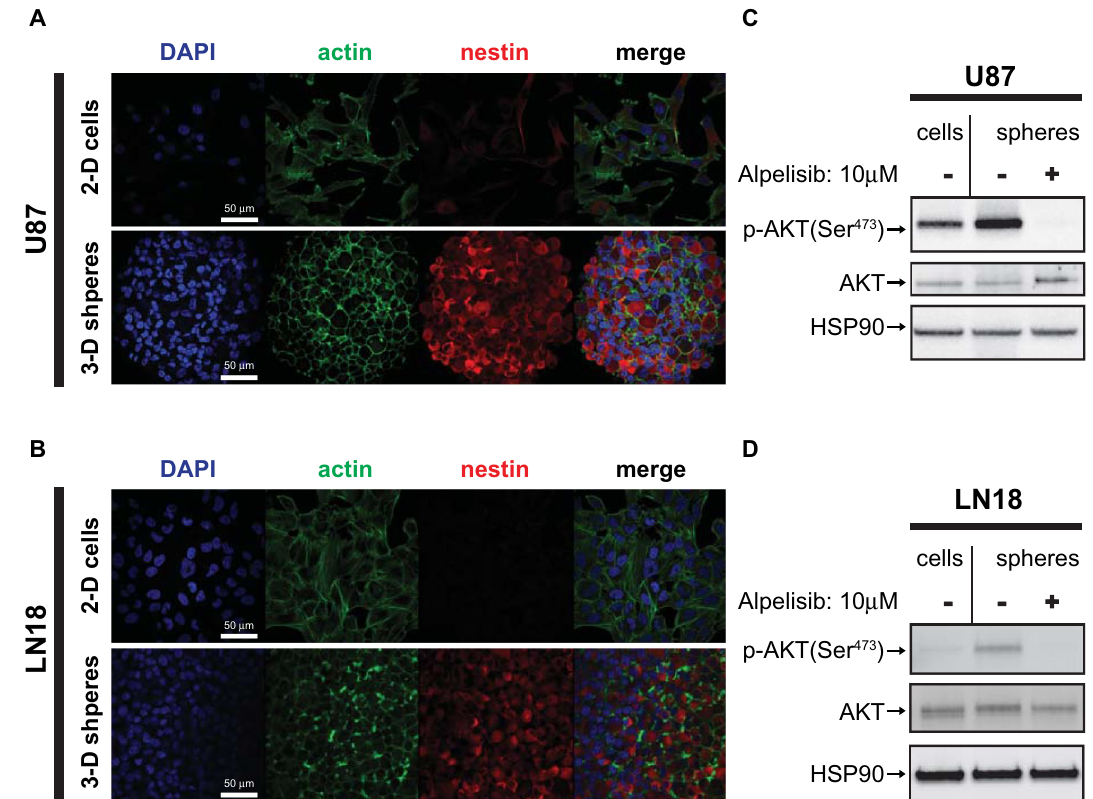
Figure 1. Increased PI3K/AKT activation in nestin expressing 3-D spheroids. ( A , B ) U87 ( A ) and LN18 ( B ) cells were grown in 2-D adherent cell culture (top panels) or as 3-D spheroids in cancer stem cell medium (bottom panels) and stained for DNA (blue), actin (green) or nestin (red). Corresponding 2-D and 3-D confocal microscopy images were acquired using identical settings. Scale bar, 50 µm. ( C , D ) U87 ( C ) or LN18 ( D ) cells were grown as 2-D monolayer (cells) or 3-D spheroids (spheres), treated with alpelisib (10 µM, 90 min), and subjected to immunoblotting using rabbit anti p-AKT(Ser 473 ) or HSP90 or mouse anti AKT antibodies simultaneously, followed by detection using anti-rabbit HRP or anti-mouse AlexaFlour488 secondary